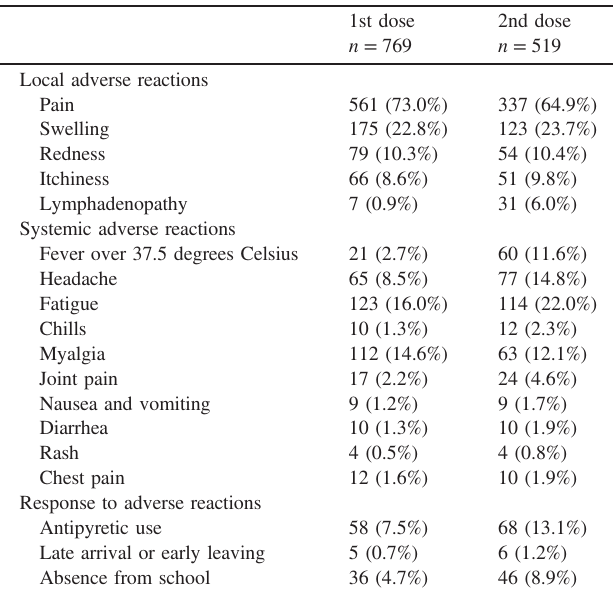
Table 1. Adverse reactions after primary dose of Comirnaty for children aged 5 to 11